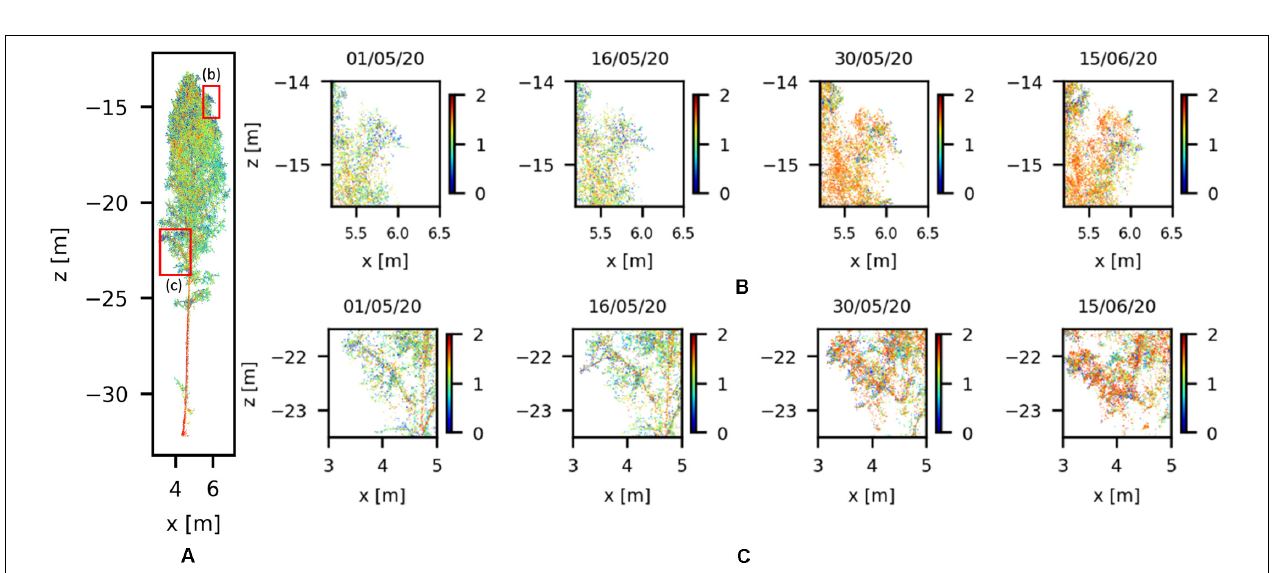
FIGURE 6 | Seasonal variation in a Silver birch crown in the voxel space between May 01 (a) and June 15 (b) . The color scale presents the number of points per voxels with 0.10 m dimension.